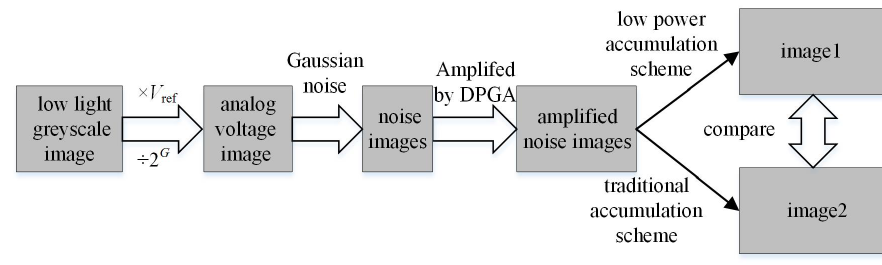
Figure 5. Block diagram of the MATLAB behavioral simulation.